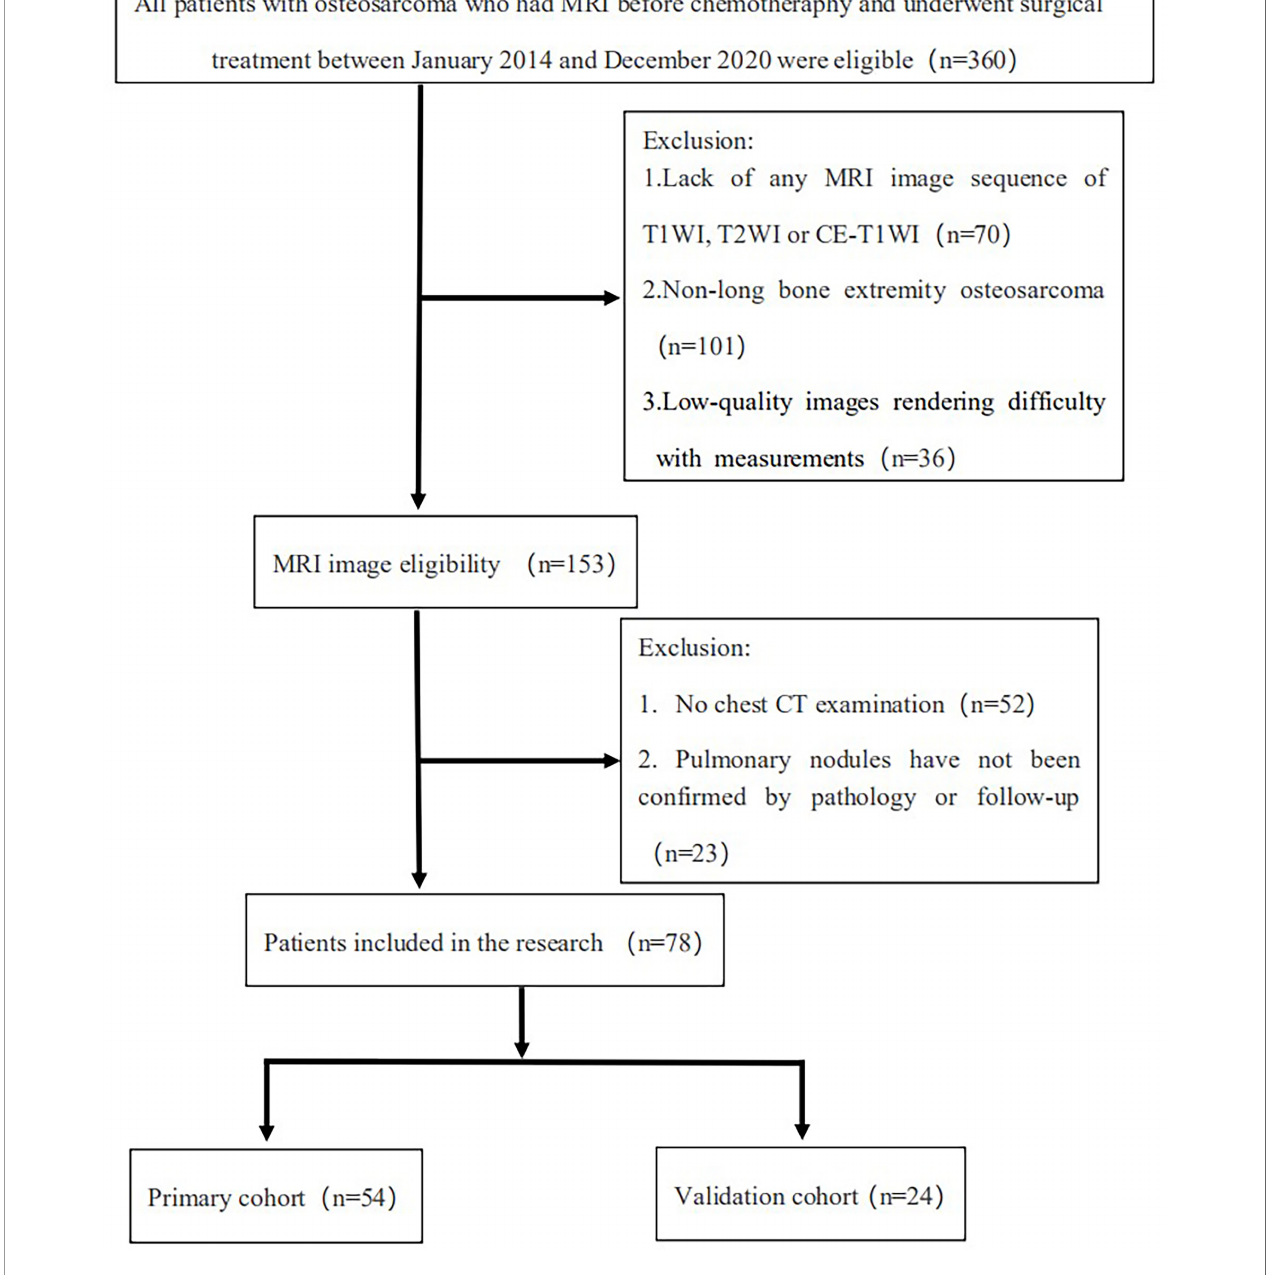
FIGURE 1 | Flow chart of the study population with exclusion